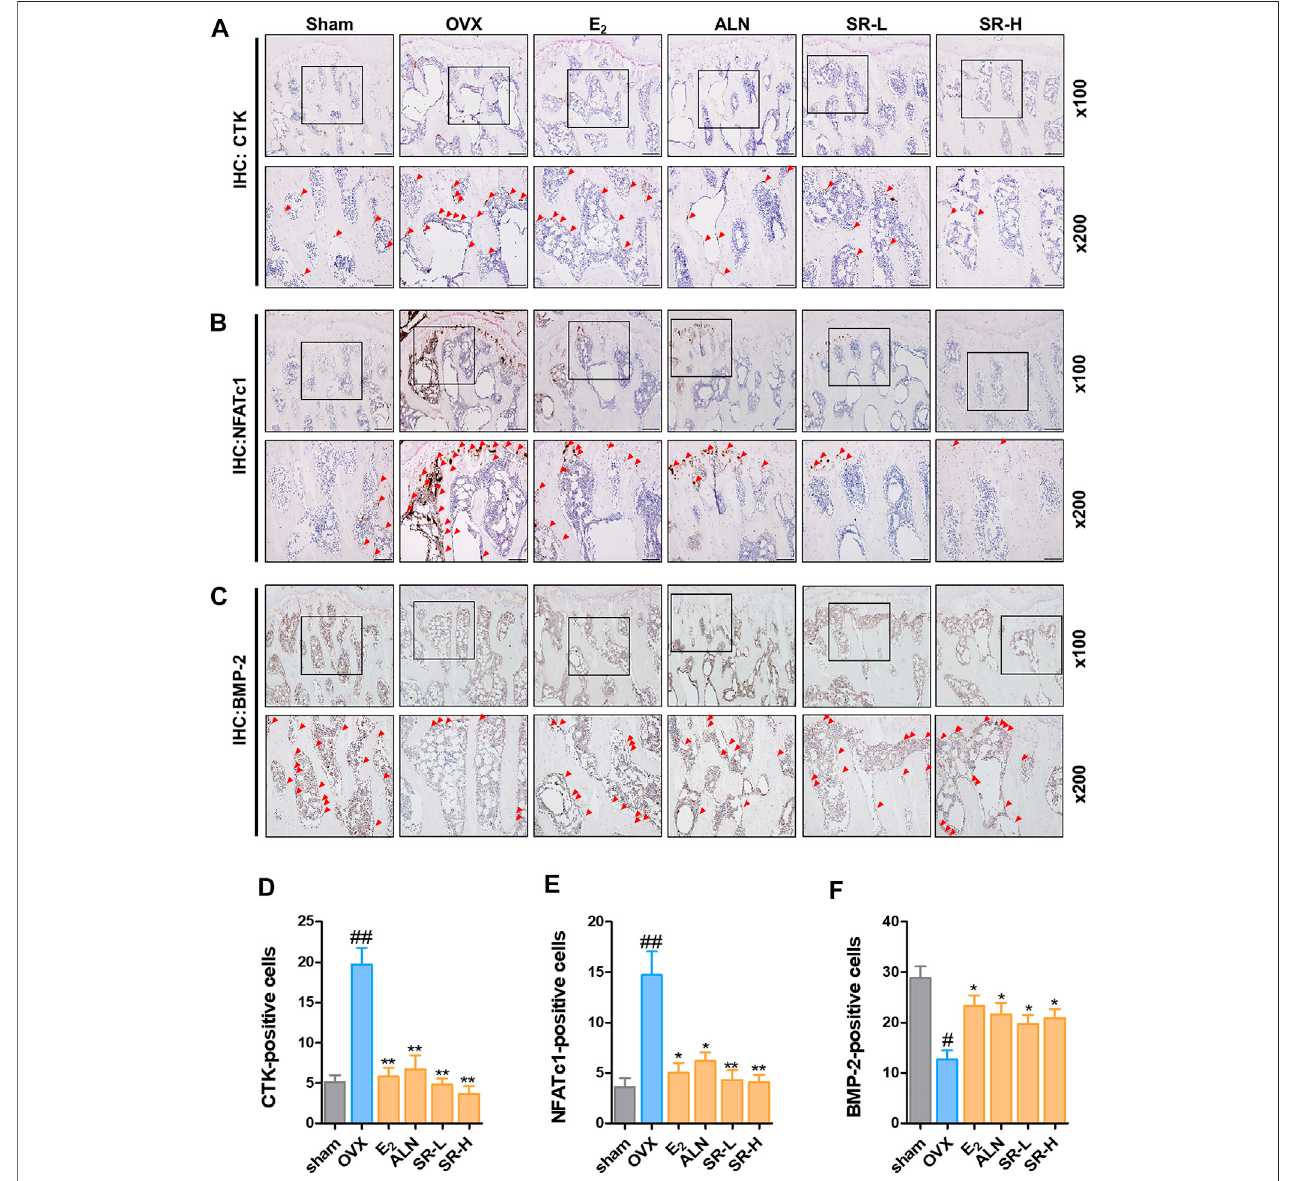
FIGURE10| EffectofSRonhistopathologicalexaminationintheOVX-inducedrats. (A) CTK-, (B) NFATc1-and (C) BMP-2-positivecellsweremeasuredusingIHC staining. (D) The number of CTK- (E) NFATc1- and (F) BMP-2-positive cells was counted using ImageJ version 1.46. The results are presented as the mean ± SEM of each experimental group ( n (cid:2) 8). Statistical analysis was performed using one-way ANOVA followed by Dunnett ’ s post hoc test. ## p < 0.01, # p < 0.05 vs. the normal group (sham-operation group); * p < 0.05, ** p < 0.01 vs. the control group (OVX-induced group).